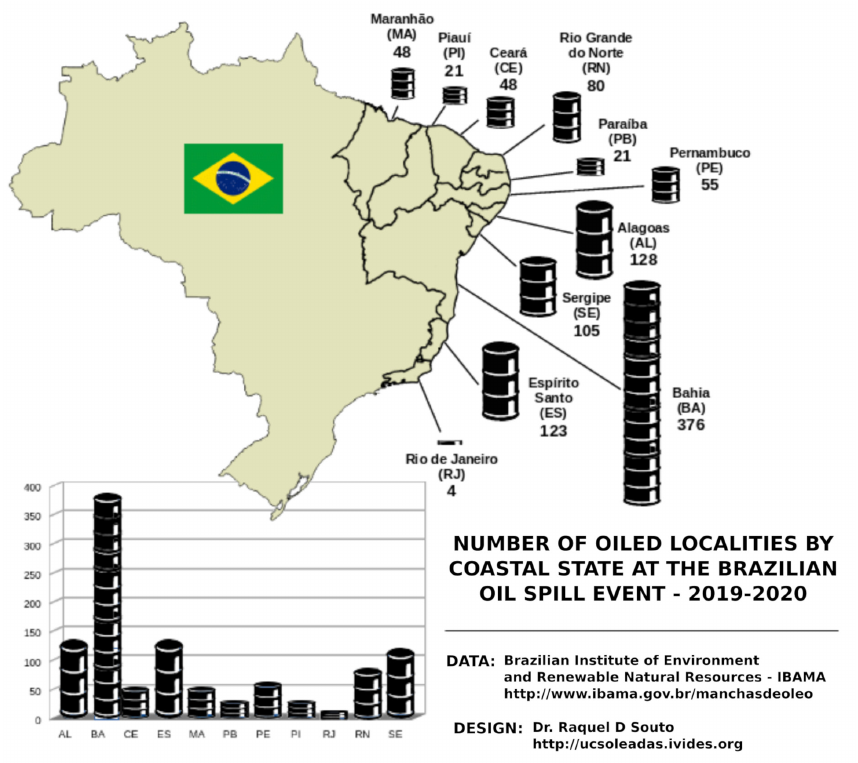
Figure 4. Percentual distribution of the retired oil in each Brazillian coastal state, according to the official data. Translated from